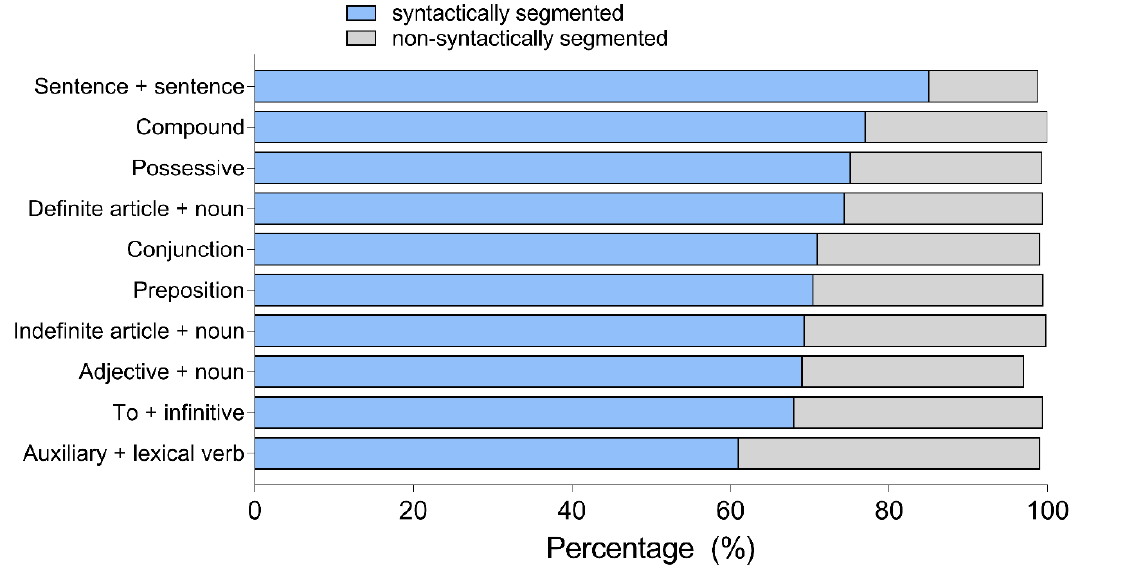
Figure 3. Preferences for SS and NSS subtitles by linguistic units in Experiment 1.